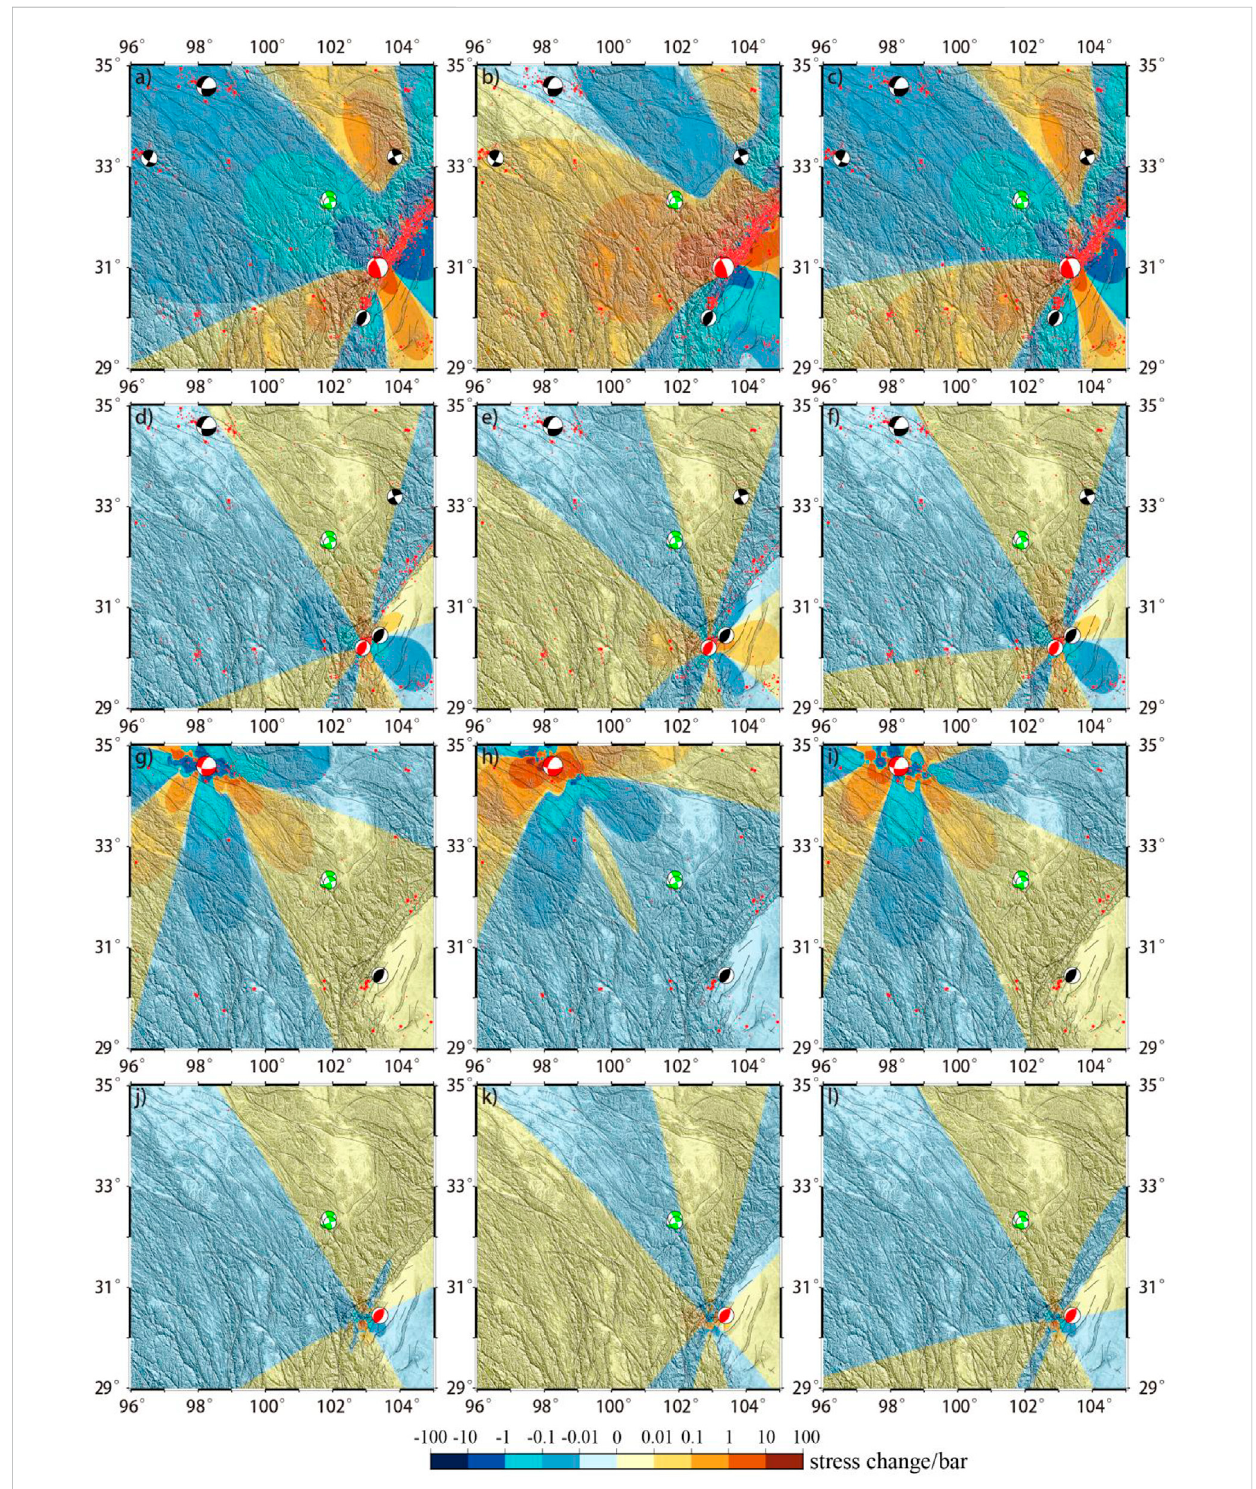
FIGURE 4 Contour map of Coulomb stress change in the 2022 Maerkang earthquakes. The red beach balls are source events, the green beach balls are receiving events, and the black beach balls are events between the source and receiving events. (A – C) Effects of the postseismic shear stress change, normal stress change, and Coulomb stress change of the 2008 Wenchuan earthquake on the 2022 Maerkang earthquakes. (D – F) Same display as for effects of the 2013 Lushan earthquake on the 2022 Maerkang earthquakes. (G – I) : Same display as for effects of the 2021 Maduo earthquake on the 2022 Maerkang earthquakes. (J – L) Same display as for effects of the 2022 Lushan earthquake on the 2022 Maerkang